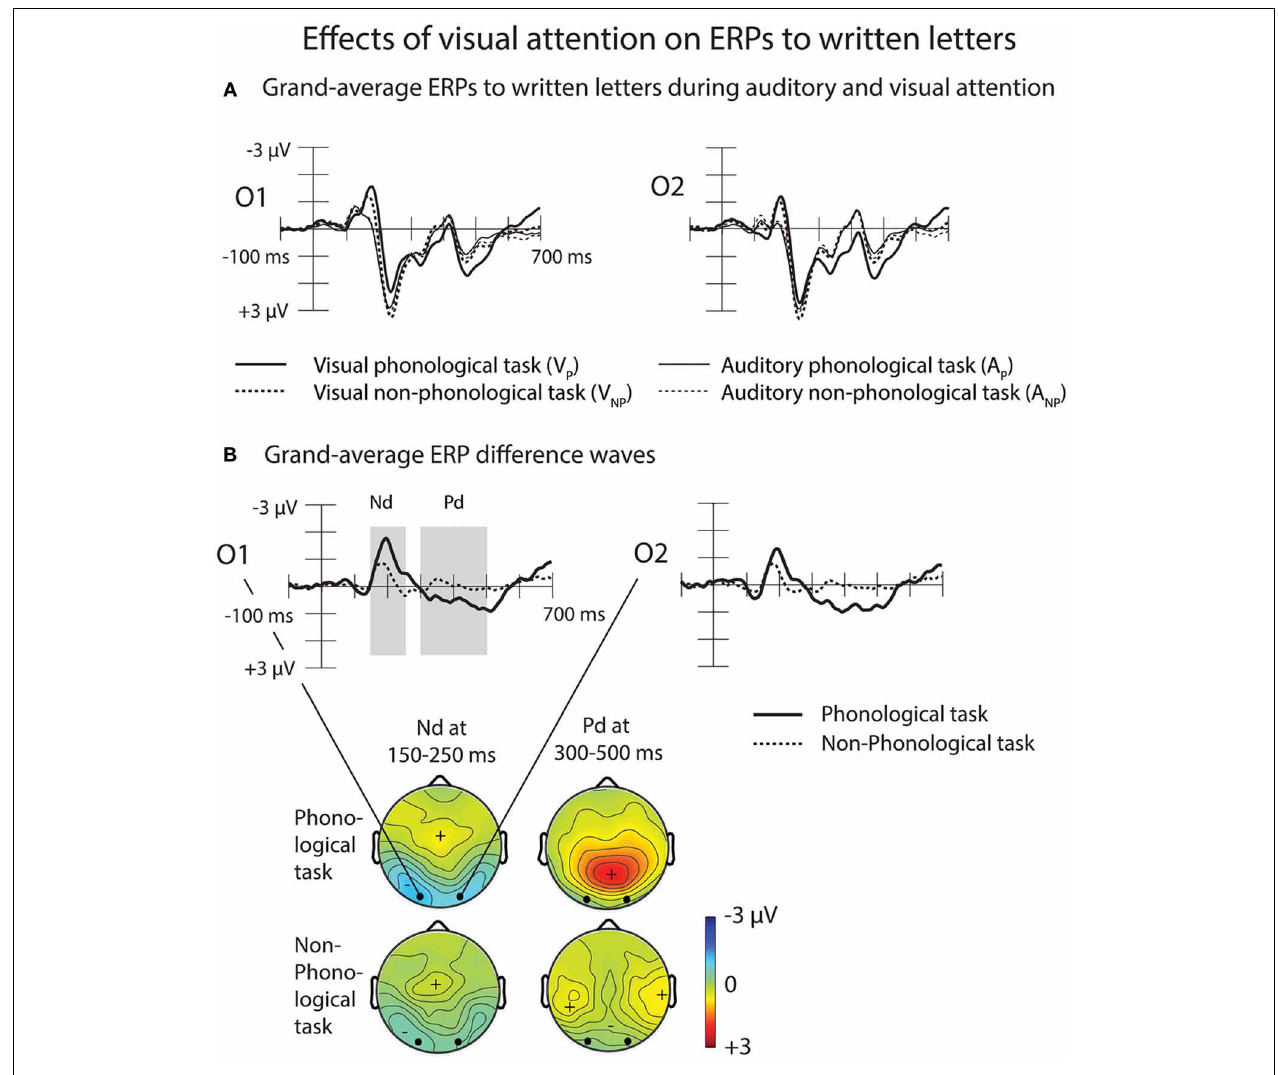
FIGURE 6 | Effects of visual attention on ERPs to written letters. (A) Grand-average ERPs to written letters during auditory and visual attention at the O1 and O2 electrodes. (B) Effects of visual attention on ERPs to written letters at the O1 and the O2 electrodes illustrated by difference waves obtained by subtracting grand-average visual ERPs during auditory phonological tasks (solid lines, data combined across the left-ear and right-ear phonological tasks) and during auditory non-phonological tasks (dotted lines, data combined across the left-ear and right-ear non-phonological tasks) from